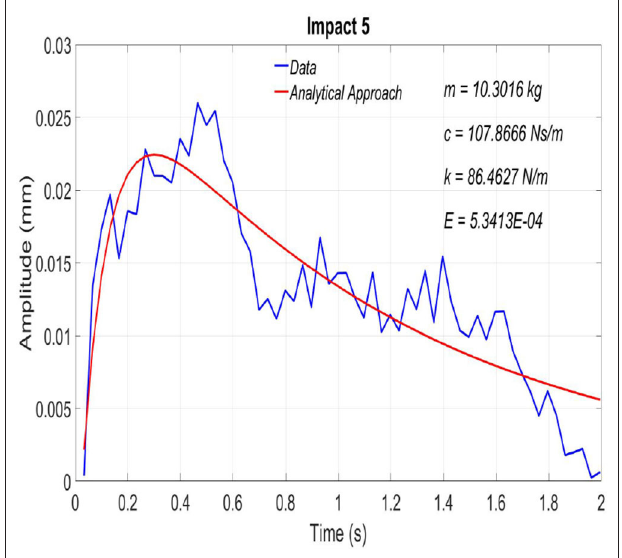
FIGURE 8 | Test 5, Optical characterization (blue) and Analytical results (red).